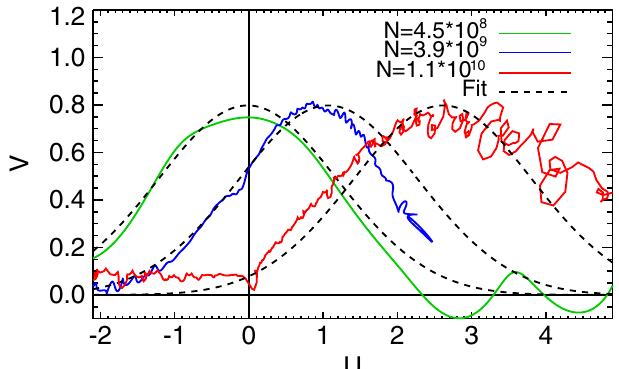
FIG. 5. (Color) Stability diagrams obtained from the BTF shown in Figs. 3 and